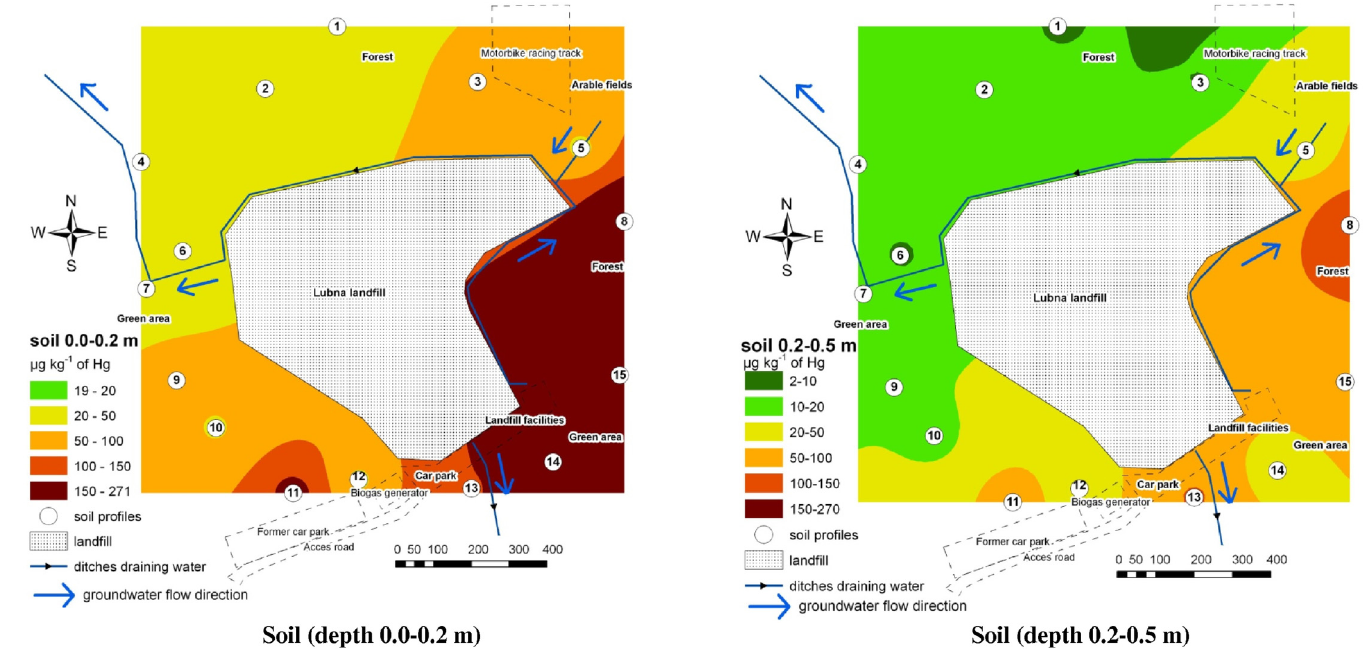
Fig 1. Contamination of the environment with THg based on the accumulated concentration of this element in soil.